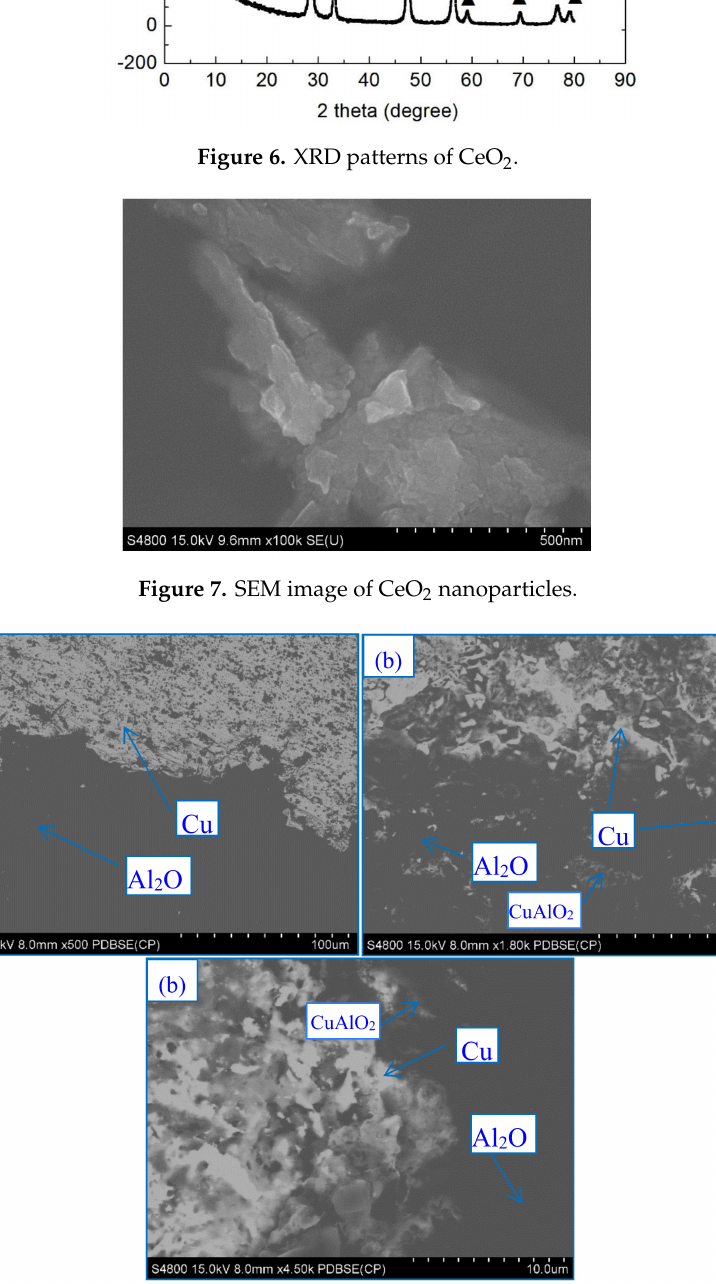
Figure 8. Backscattered electron imaging (BSE) images at samples’ bonded temperatures: ( a ) without CeO 2 at bonded temperature 1300 ◦ C, ( b ) without CeO 2 at bonded temperature 1500 ◦ C, and ( c ) with CeO 2 at bonded temperature 1300 ◦